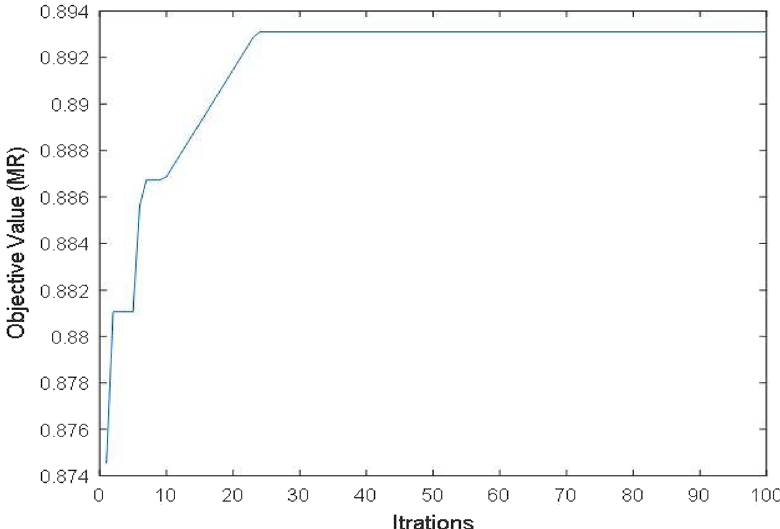
Figure 16. Iteration plot for MR.